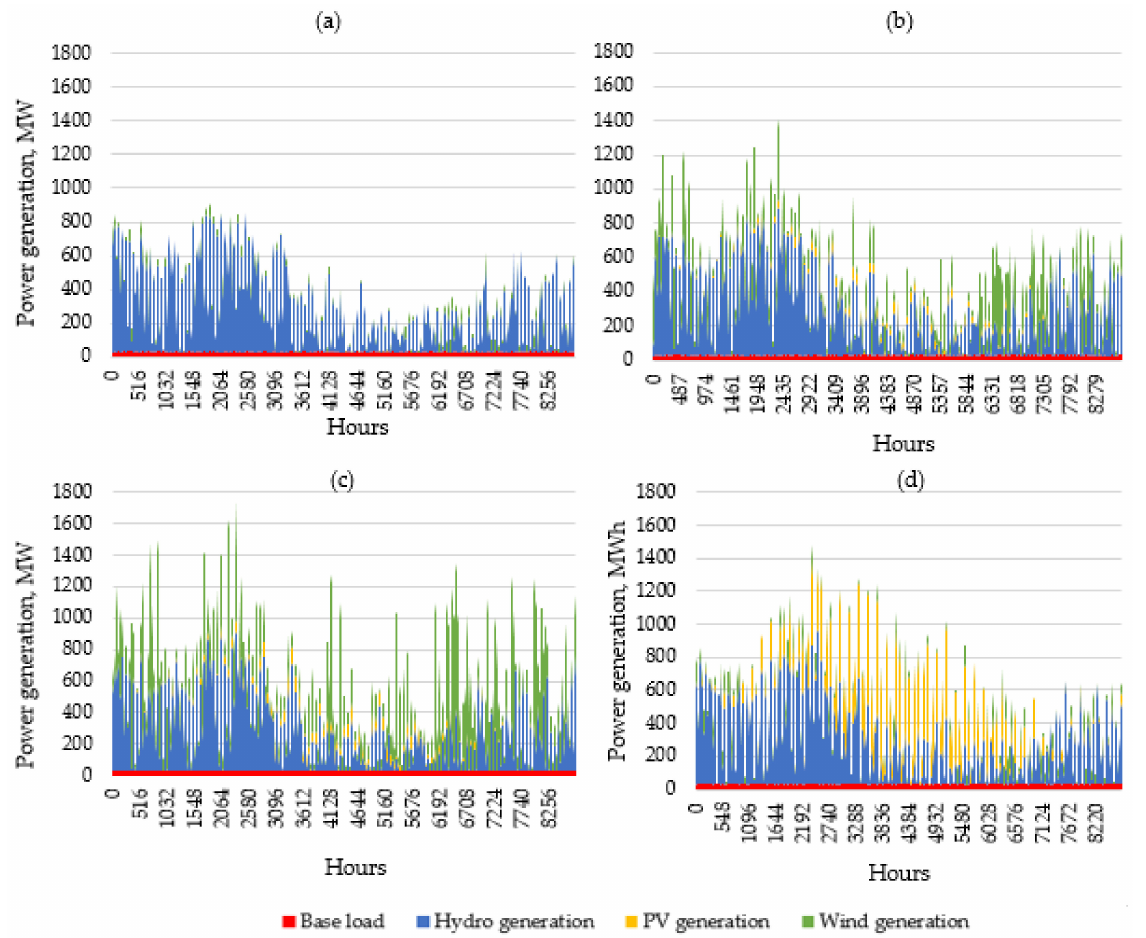
Figure 13. Hourly electricity production by resource type for different scenarios. ( a ) Scenario 1; ( b ) Scenario 2; ( c ) Scenario 3; ( d ) Scenario